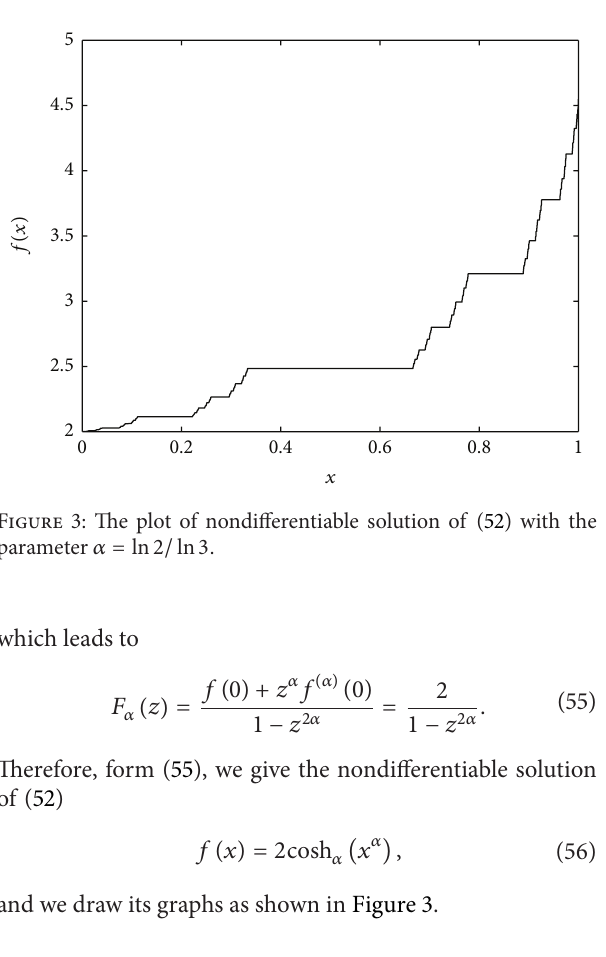
Figure 2: The plot of nondifferentiable solution of (47) with the parameter 𝛼 = ln 2/ ln 3 .